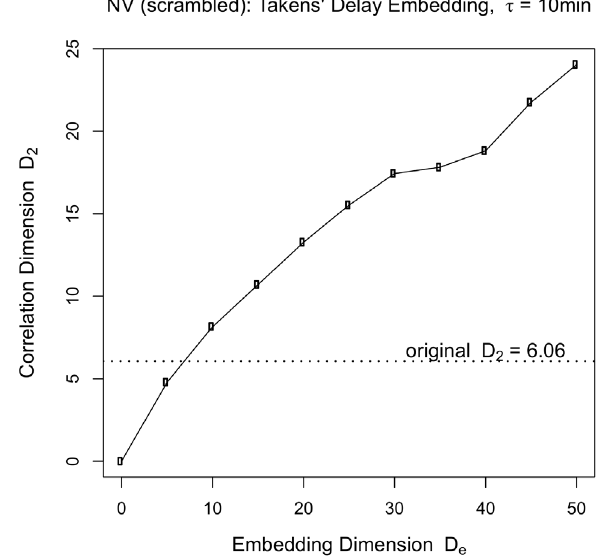
Figure 5. Repeat Takens’ delay embedding procedure as in Fig. 4, but with a randomly permuted time series of NV’s images. As the embedding dimension is increased, the correlation dimension of the reconstructed delay embedded vectors keeps rising and never asymptotes, demonstrating that the dimensional structure of the data is dynamic in